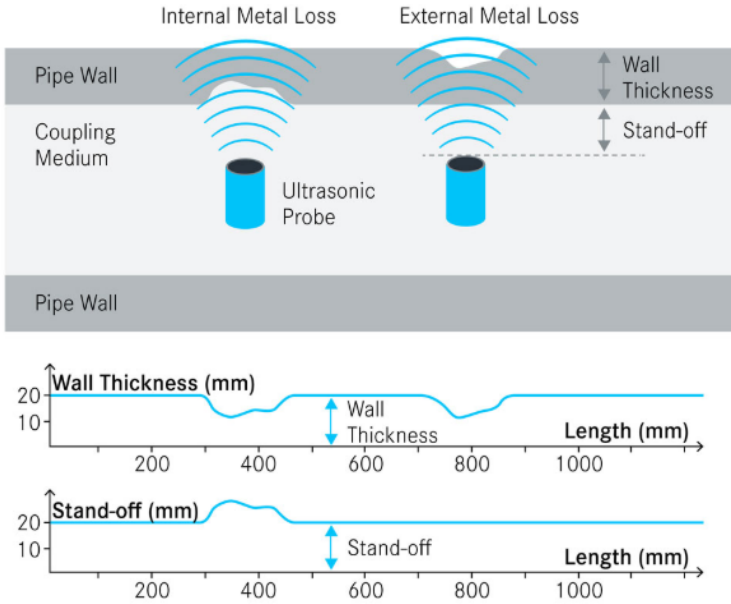
Figure 5. Schematic of the ultrasonic testing (UT) wall thickness measurements with capablities to discriminate internal and external mass loss [39] (Courtesy of NDT Global LLC).